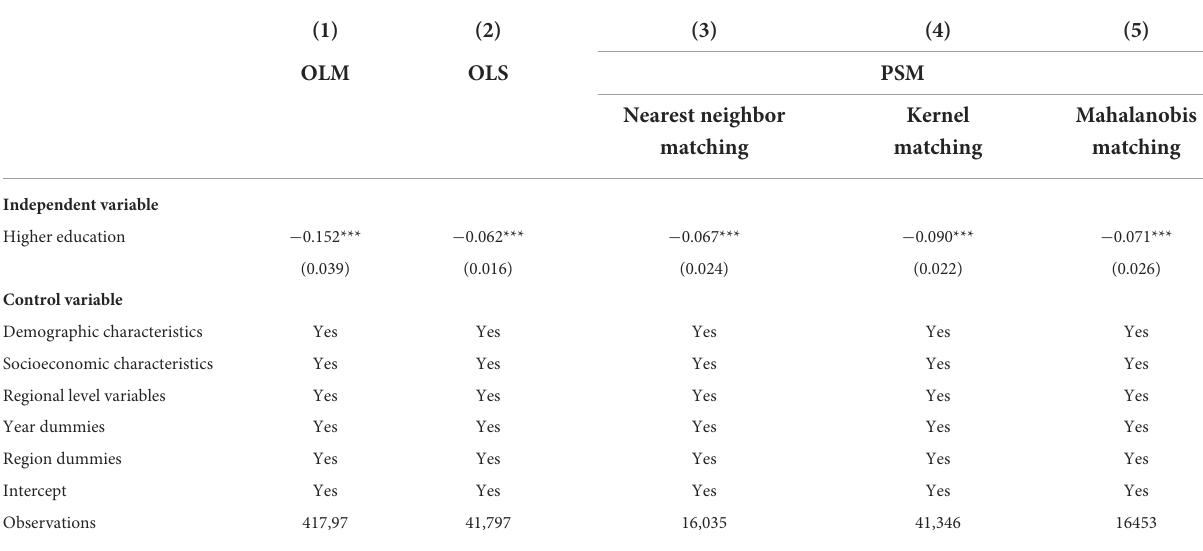
TABLE 3 Robustness